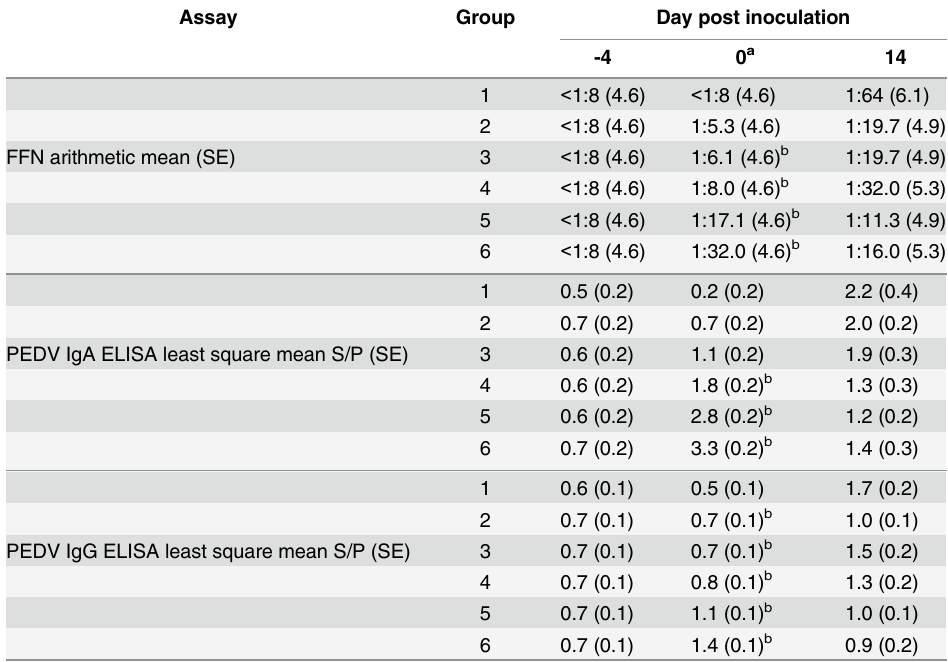
Table 2. Serum antibody levels among treatment groups by day post inoculation. Assay